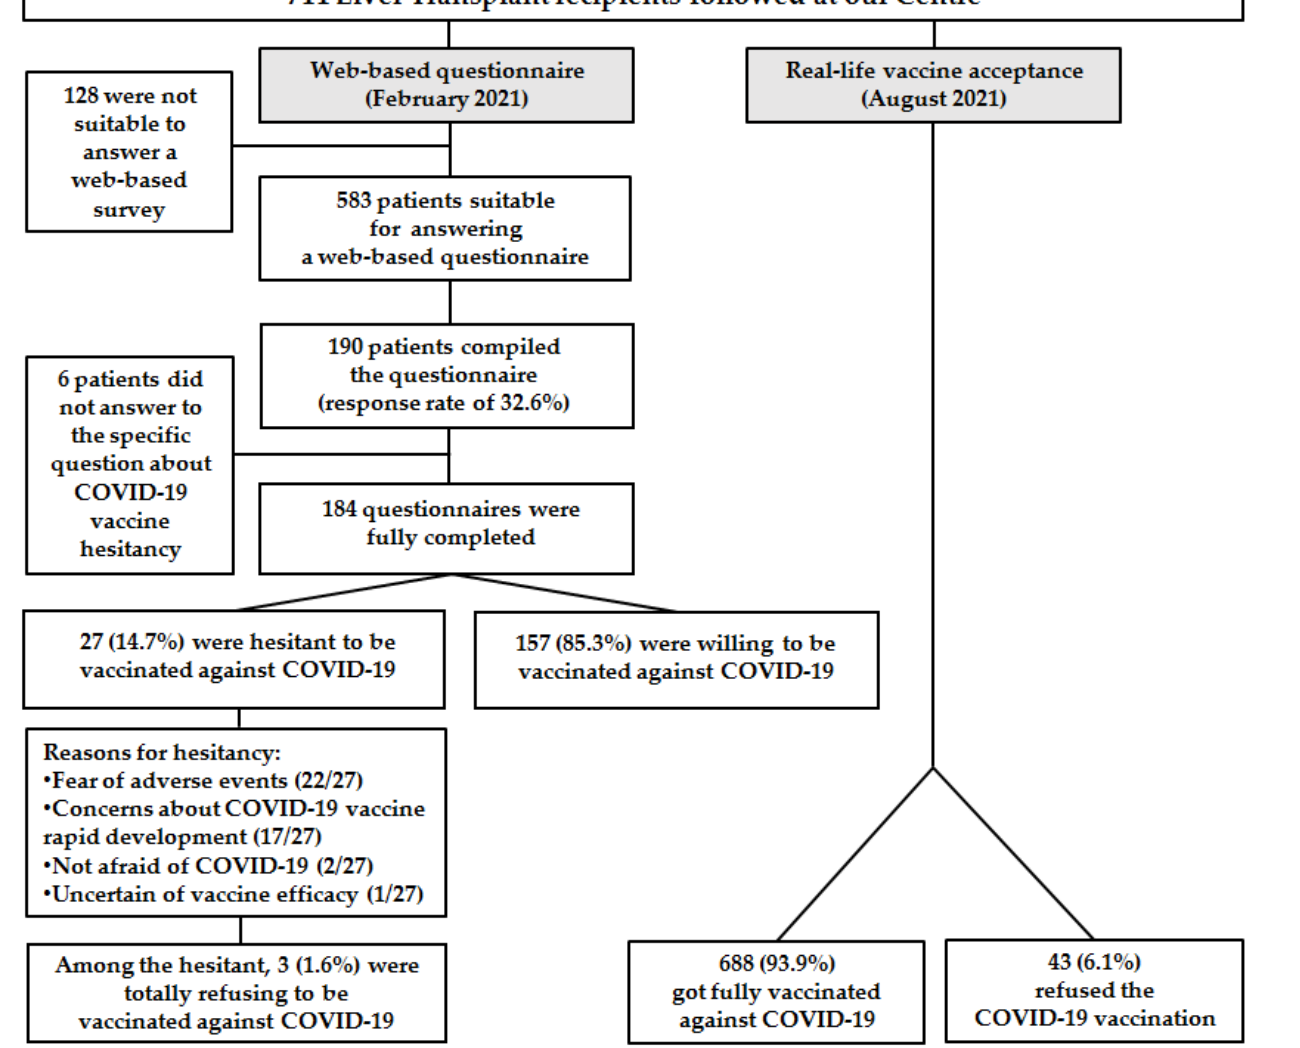
Figure 1. Flow diagram of the study of our liver transplant population showing, on the left side, COVID-19 vaccination willingness and hesitancy (web-based questionnaire) and, on the right side, the real-life COVID-19 acceptance.